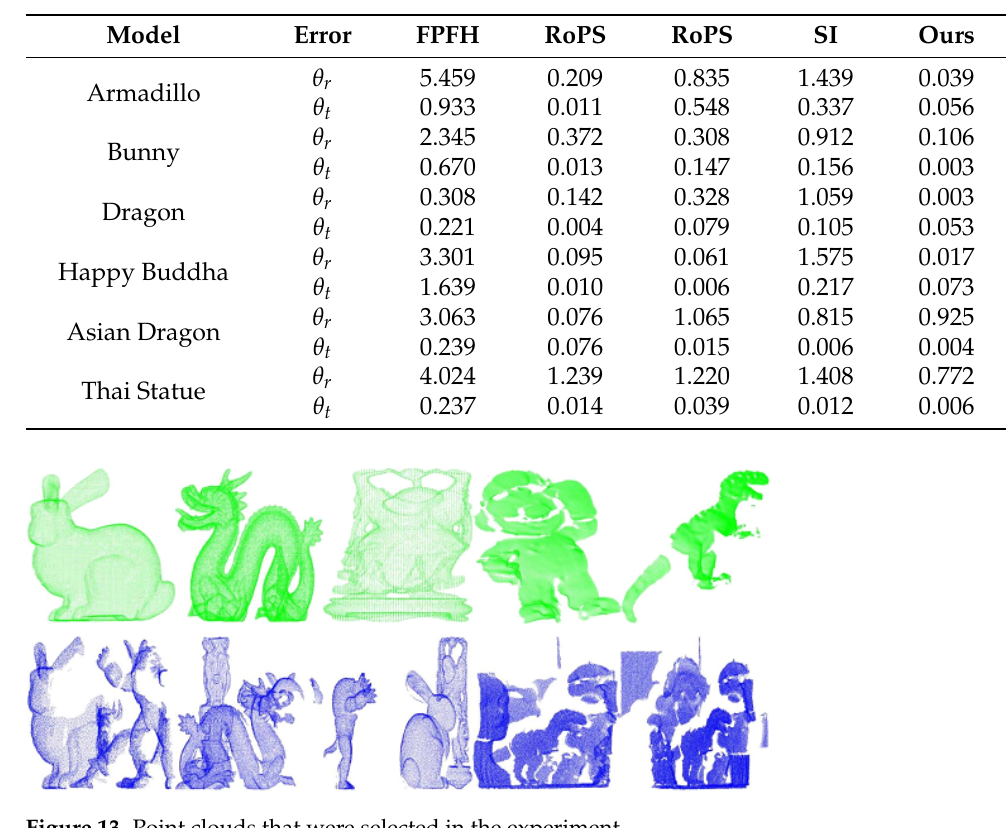
Table 1. Errors of Stanford 3D models.